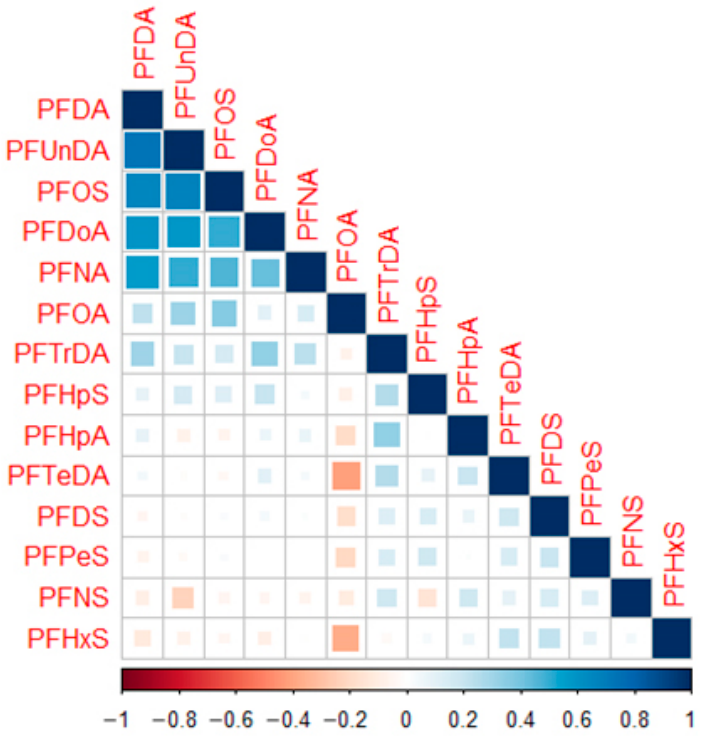
Figure 2. Spearman correlation coefficients for PFASs in